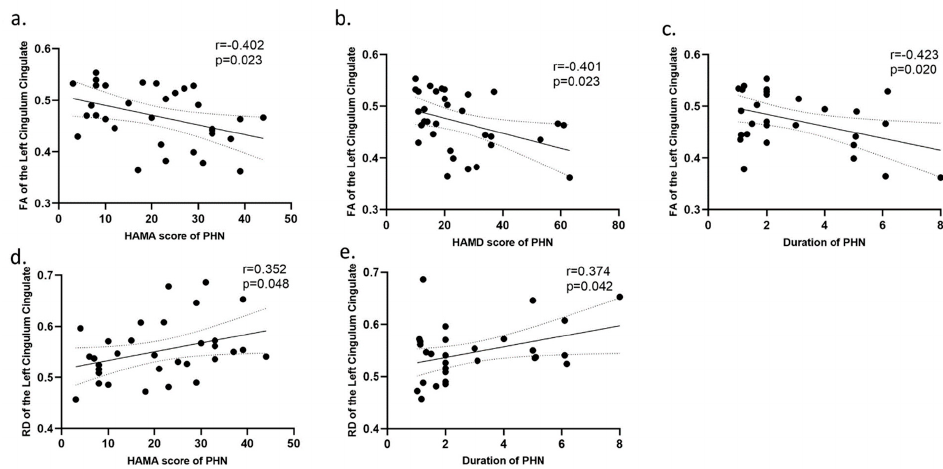
Figure 3. Correlation analysis between the diffusion properties and the clinical characteristics ( a – e ). Abbreviations: HZ, herpes zoster; PHN, postherpetic neuralgia; fractional anisotropy (FA); radial diffusivity (RD); HAMA, Hamilton Anxiety Scale; HAMD, Hamilton Depression